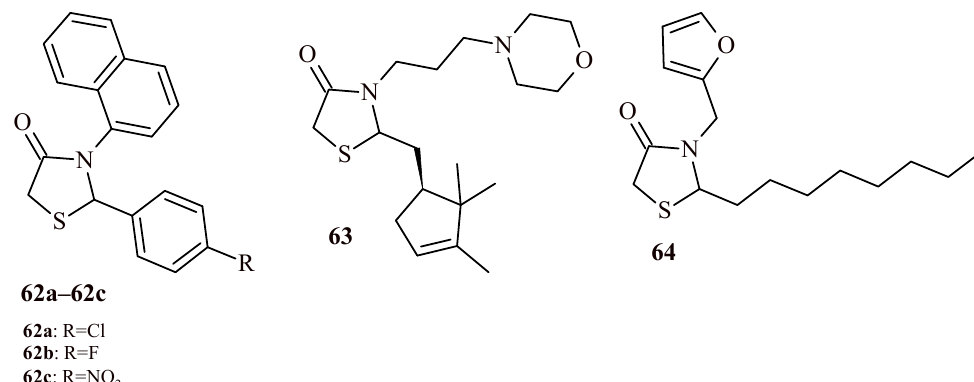
Figure 27. The structure of various 2-aryl/alkylthiazolidin-4-ones with potential anti-inflammatory and analgesic activity.